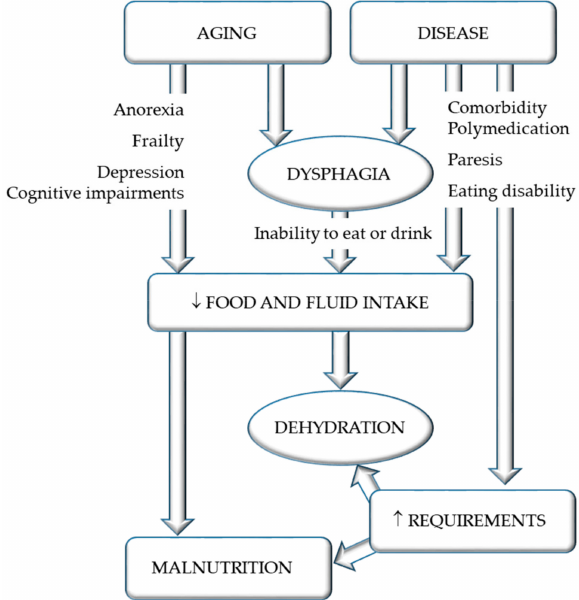
Figure 1. Risk factors for dehydration in dysphagia, modified after the work of